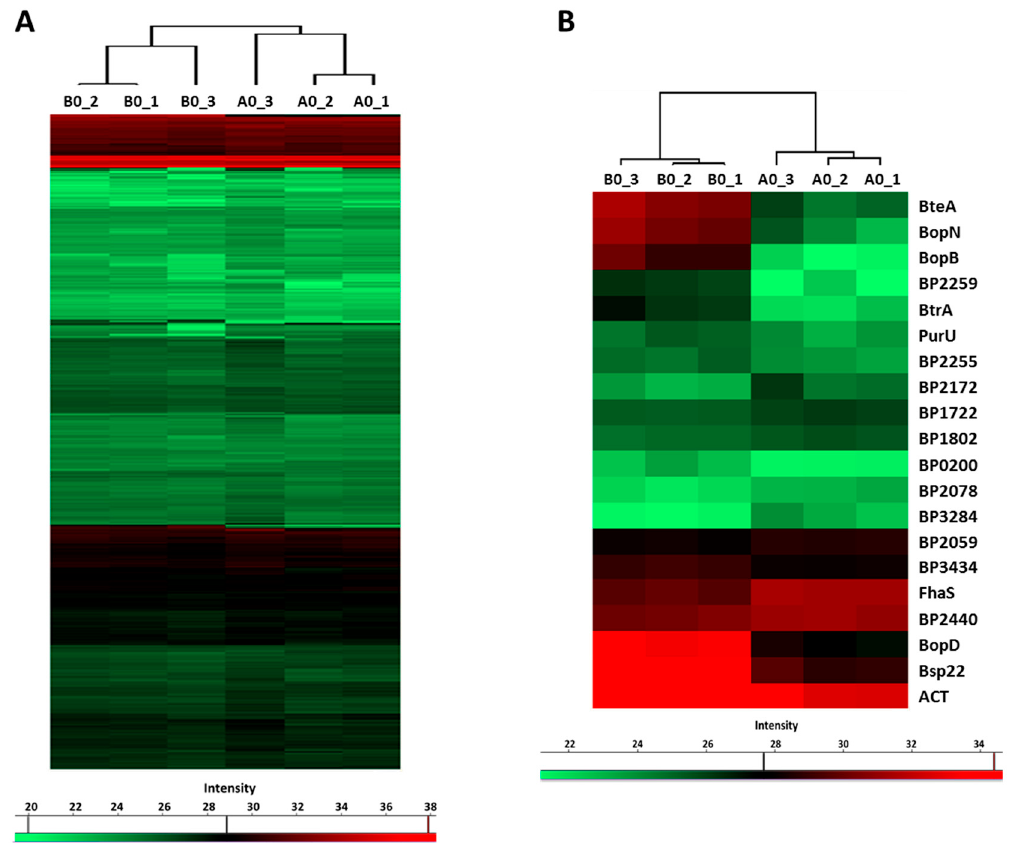
Figure 4. Previous exposure to blood has only a limited impact on protein secretion. Proteins were isolated from supernatants of cultures inoculated from CHAB plates (B0 cultures) and from CHA plates (A0 cultures). ( A ) Heatmap showing hierarchical clustering performed on label-free quantification (LFQ) intensity values of all 751 secreted proteins which passed the detection criteria. ( B ) Heatmap showing hierarchical clustering of all significantly (q-value < 0.1) differentially secreted proteins. Color-coded scale bars denote the LFQ intensities of identified proteins. Table 2. List of proteins significantly differentially secreted upon previous exposure to blood.